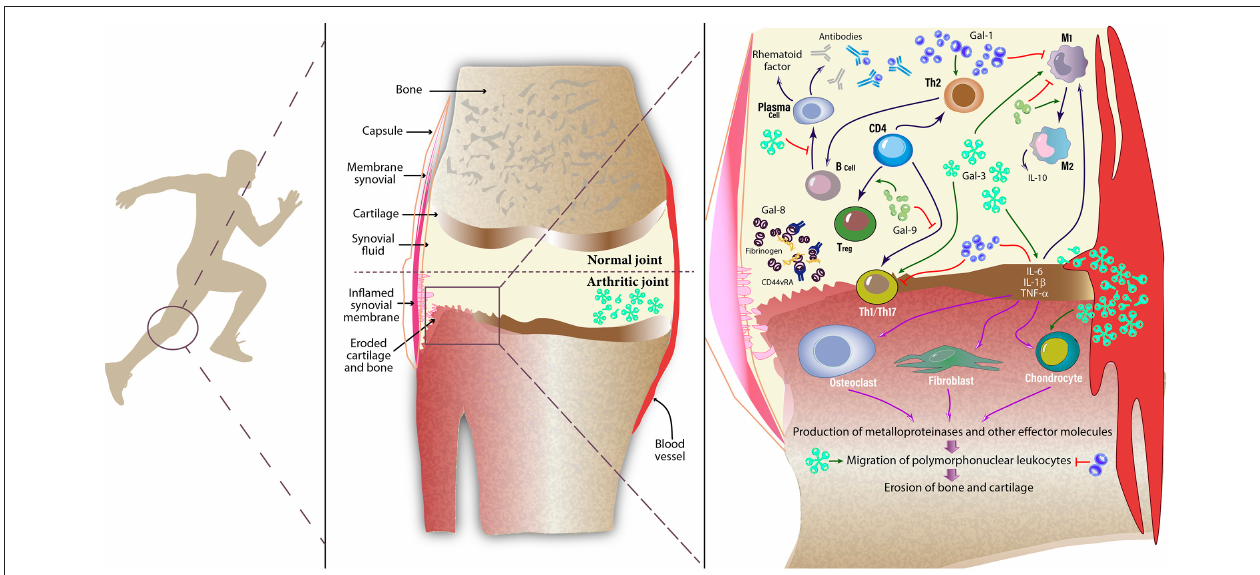
FIGURE 1 | Role of galectins in inflamed synovial tissue. Galectins are expressed by a number of inflammatory cells (both innate and adaptive immune cells), endothelial cells, stromal cells, and synovial fibroblasts. These glycan-binding proteins influence a variety of cellular programs that control amplification and resolution of inflammatory responses. Galectins can behave as pro- or anti-inflammatory mediators by modulating the physiology of immune cells, including monocytes, macrophages, synovial fibroblasts, Th1, Th2, and Th17 cells, regulatory T (Treg) cells, B cells, neutrophils and mast cells. By positively or negatively regulating inflammation, galectins may directly or indirectly influence the clinical course of RA. While Gal-1 enhances a Th2-Treg response profile, polarizes macrophages toward an M2 phenotype and induces apoptosis of Th1 and Th17 cells, Gal-3 activates fibroblasts and induces secretion of pro-inflammatory cytokines. Circulating autoantibodies reduce effective Gal-1 concentrations in synovial fluid of patients with RA. On the other hand, Gal-9 controls CD4 + T cell functions through binding to TIM-3 + cells. Moreover, Gal-8 has pro-apoptotic and anti-inflammatory activity in the inflamed joint; however a soluble form of CD44 reduces availability of this tandem-repeat galectin by forming complexes with fibrinogen. Gal, Galectin; TNF, Tumor necrosis factor; IL, Interleukin; Th, T helper cell; Treg, regulatory T cells; M1, pro-inflammatory macrophage; M2, anti-inflammatory